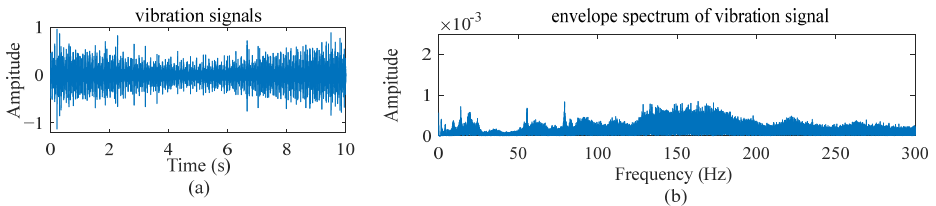
Figure 3. Vibration signal and its envelope spectrum under decreasing speed and then increasing working conditions when an inner raceway fault occurs.